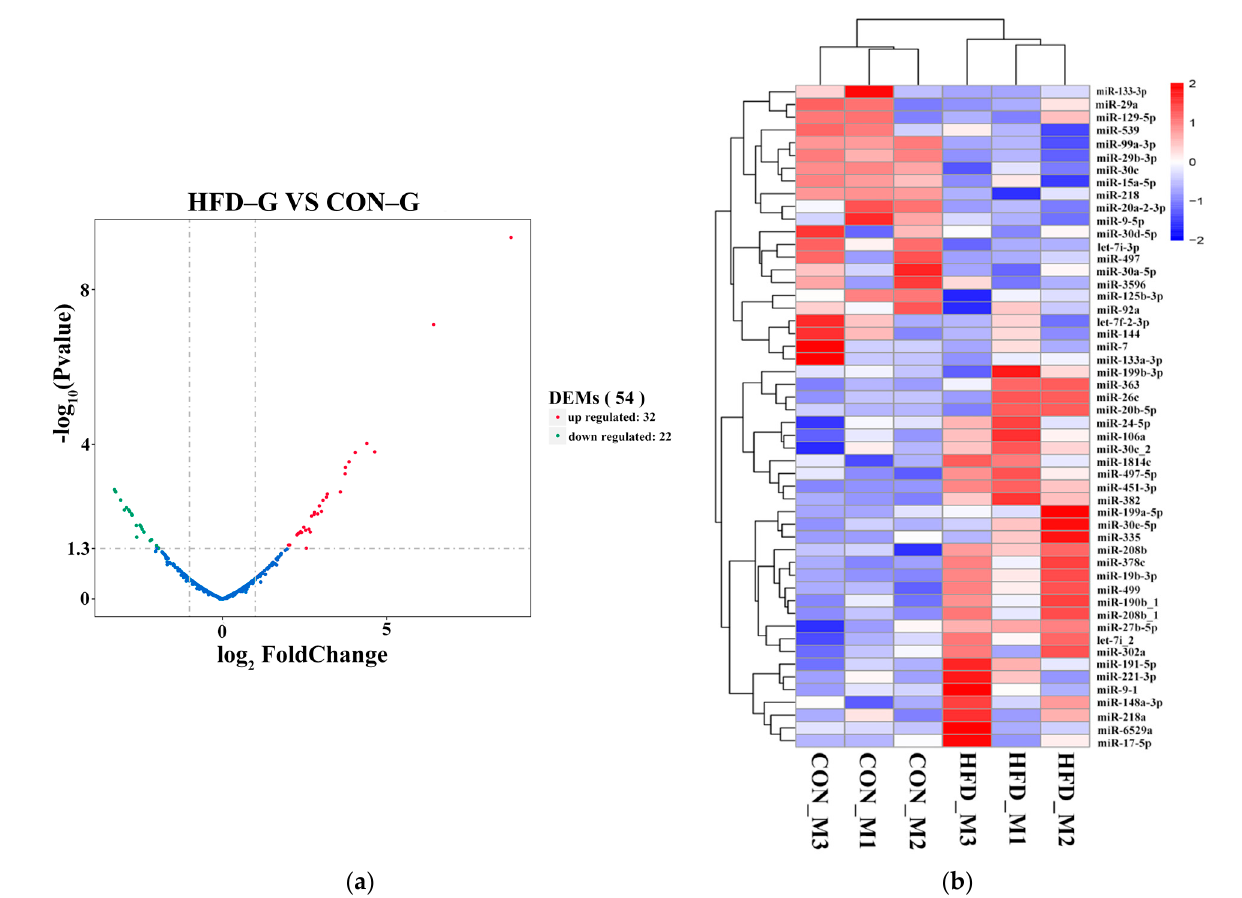
Figure 2. Map of identified DEMs in skeletal muscle samples from CON–G and HFD–G rabbits. ( a ) Volcano map of DEMs in muscle. Green, blue, and red represent significantly reduced miRNAs, non-significant miRNAs, and upregulated miRNAs, respectively. ( b ) Heatmap of DEMs. Blue and red represent downregulated and upregulated miRNA expression, respectively. Cluster analysis was conducted for sample and differential miRNAs. Table 2. Differential expression information of top 10 upregulated and top 10 downregulated DEMs between CON–G and HFD–G.